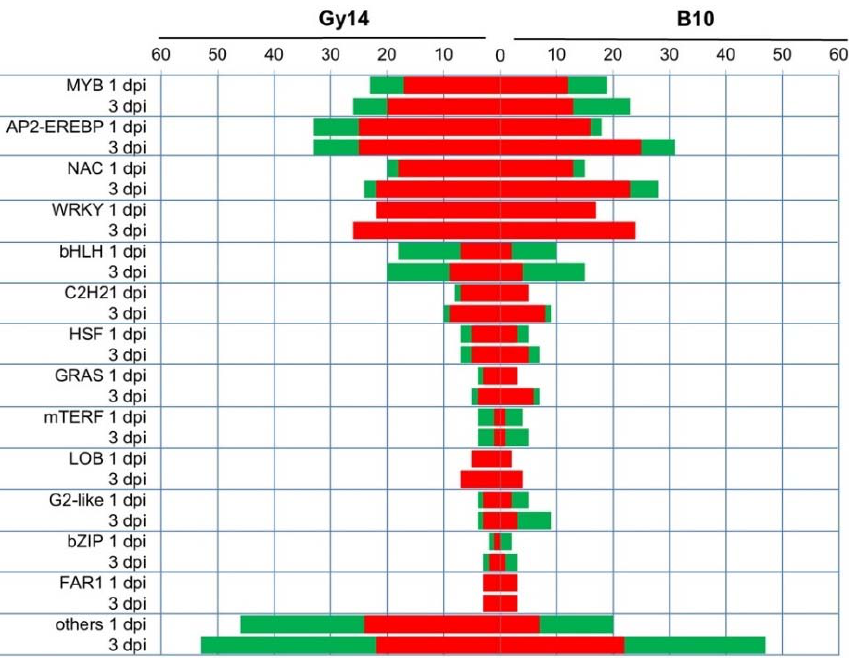
Figure 7. The summary of differentially expressed transcription factors (TF-DEGs) in Gy14 and B10 lines at 1 and 3 dpi. Names of transcription factor families/subfamilies are based on classification implemented by the Plant Transcription Factor Database [31]. Red and green indicate up- and down-regulated TF-DEGs, respectively.